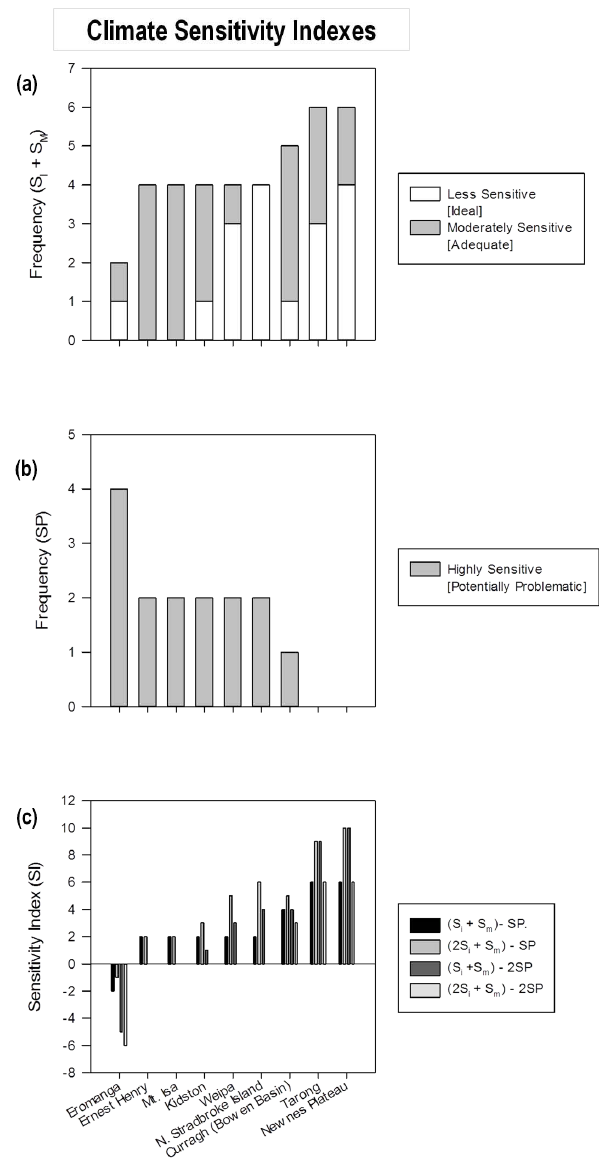
Fig. 2. Frequency of (a) favourable criteria (both ideal ( S i ) + mod- erately sensitivity ( S m ) ) and (b) unfavourable potentially problem- atic (SP) that eventually build (c) the aggregated sensitivity indexes. Threshold values used to determine these sensitivity criteria are shown in Table